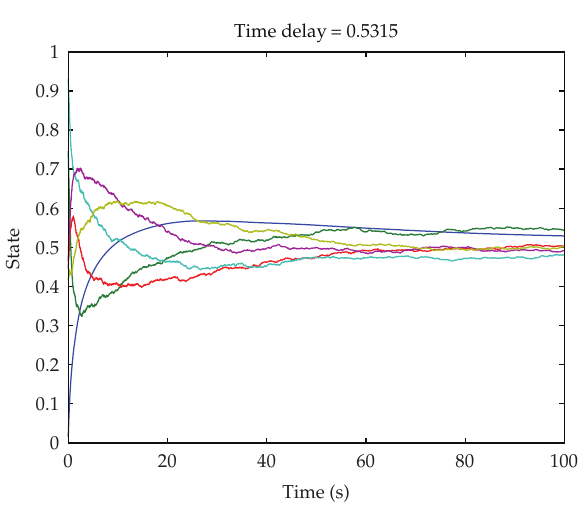
Figure 3: State trajectories under protocol (cid:7) 4.1 (cid:8) and a (cid:7) t (cid:8) (cid:6) 1 / (cid:7) t (cid:9) 1 (cid:8) .